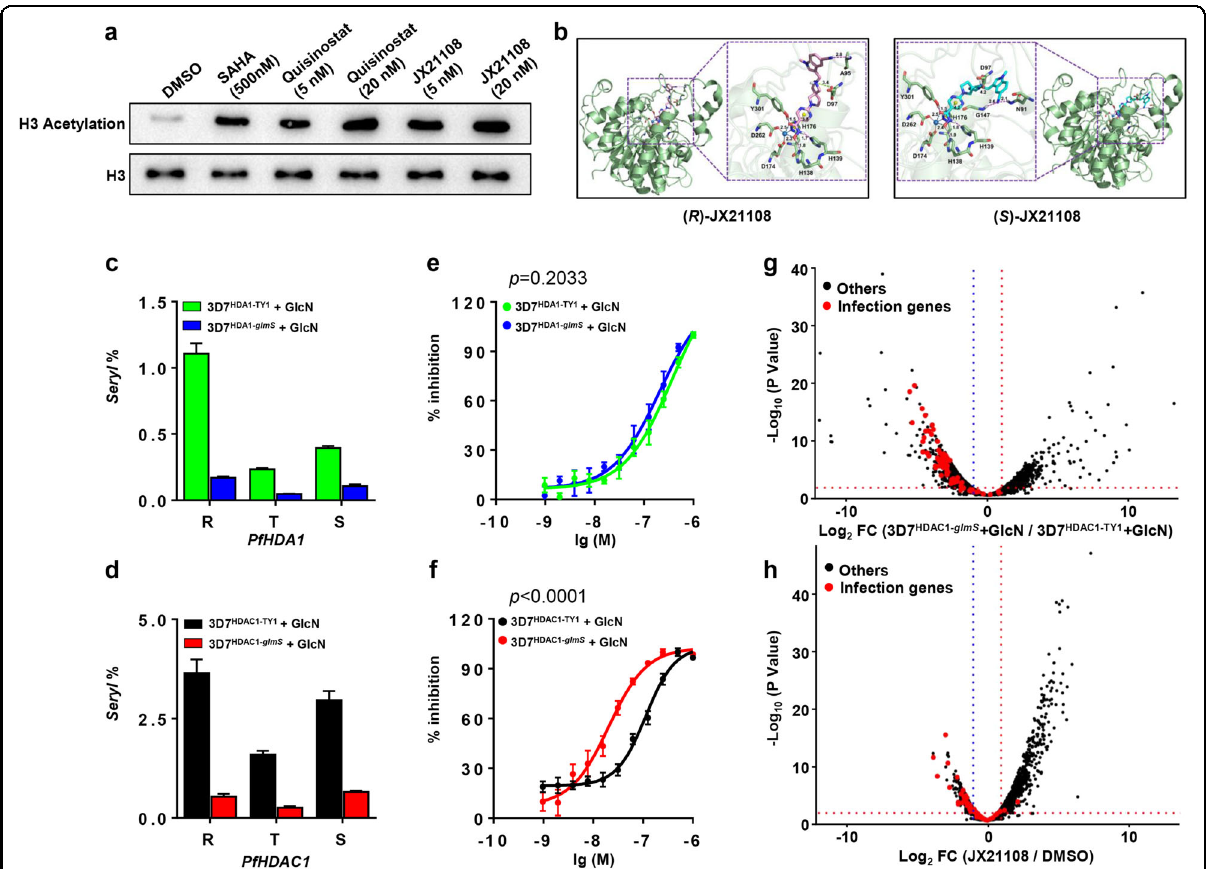
cartoon. Small molecules and key residues in PfHDAC1 are drawn as sticks. Carbons are in pink, cyan and orange in small molecules, and green in key residues. All oxygen, nitrogen, and hydrogen atoms (polar hydrogens only) are in red, blue, and white, respectively. Zn 2 + and π -bond centers are represented as blue and yellow spheres, respectively. Metal bonds, hydrogen bonds, π bonds, and ionic bonds are shown as blue, purple, yellow, and green dashed lines, respectively. The distances of these interactions are also labeled near the dashed lines and shown in angstroms. c , d RT-qPCR detecting the gene expression of PfHDA1 ( c ) and PfHDAC1 ( d ) in the transgenic parasites 3D7 HDA1-TY1 , 3D7 HDA1- glmS ( c ) and 3D7 HDAC1-TY1 , 3D7 HDAC1-